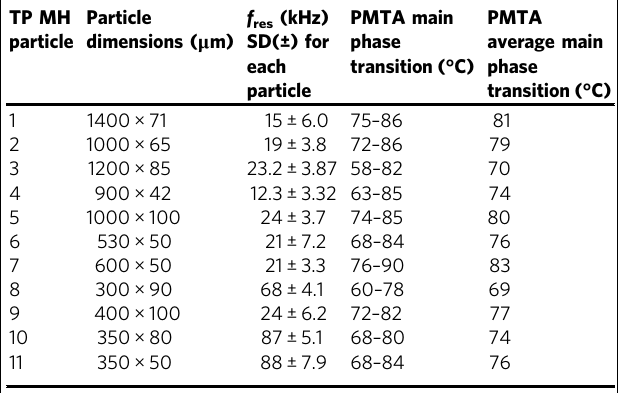
The mean width of the particles was calculated to be ∼ 71 μ